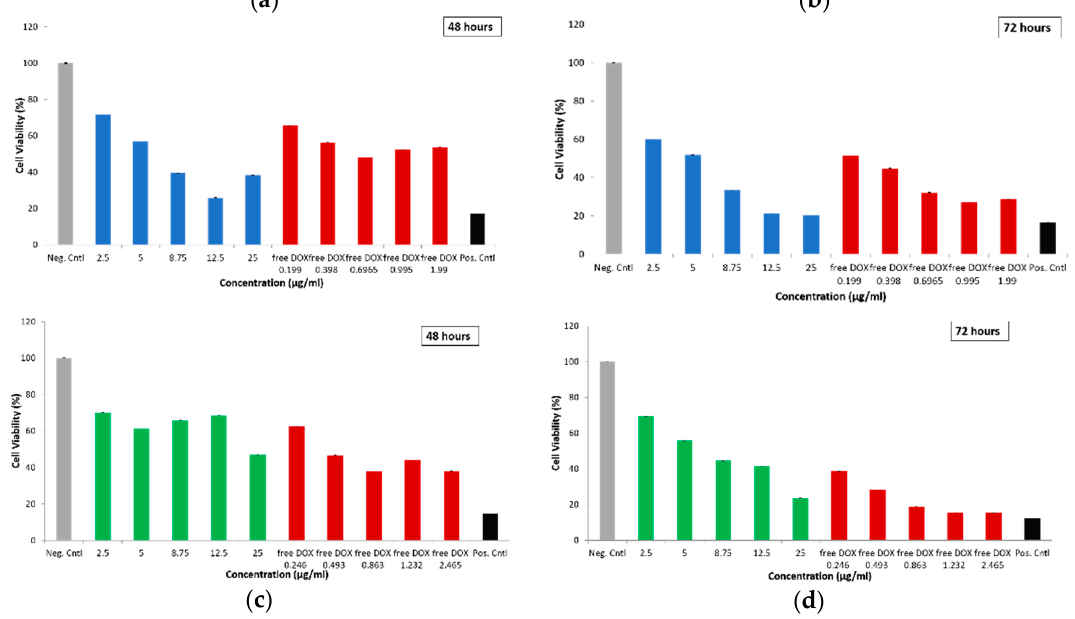
Figure 5. Cell viability of MDA-MB-231 cells as represented using WST-1 assay against the cytotoxic effect of DOX-loaded particles, i.e., DOX-loaded S-MSN@PDA ( a,b ), DOX-loaded R-MSN@PDA ( c,d ), and corresponding concentrations of free DOX with MDA-MB-231 cells at 48 and 72 h of incubation, respectively. Negative control indicates untreated cells, while positive control indicates cells treated with 0.1% Triton X-100. The measurements were performed on a plate reader.